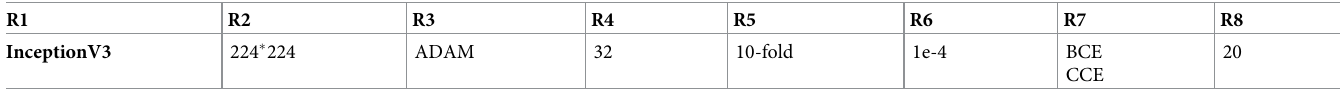
R1—Model, R2—Image Size, R3—Optimizers, R4—Mini Batch Size, R5—cross validation, R6—Initial Learning Rate, R7—Loss function, R8—Epoch, BCE—Binary cross-entropy, CCE—Categorical cross-entropy.